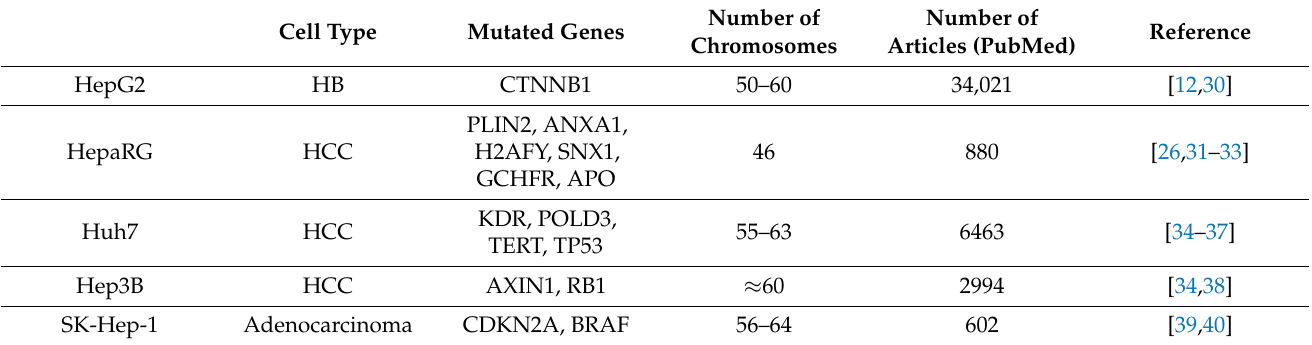
Table 1. Characteristics of the top five most studied tumor hepatic cell lines.